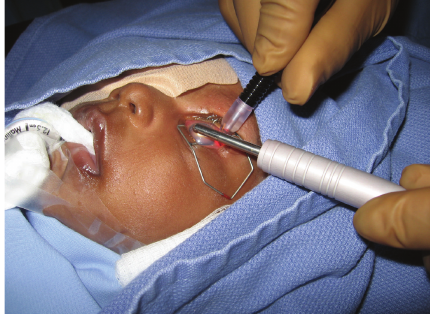
Figure 4: Transcleral diode laser cyclophotocoagulation being performed in a child with congenital glaucoma refractive to other treatments. Transillumination probe being utilized to aid in the correct localization of ciliary